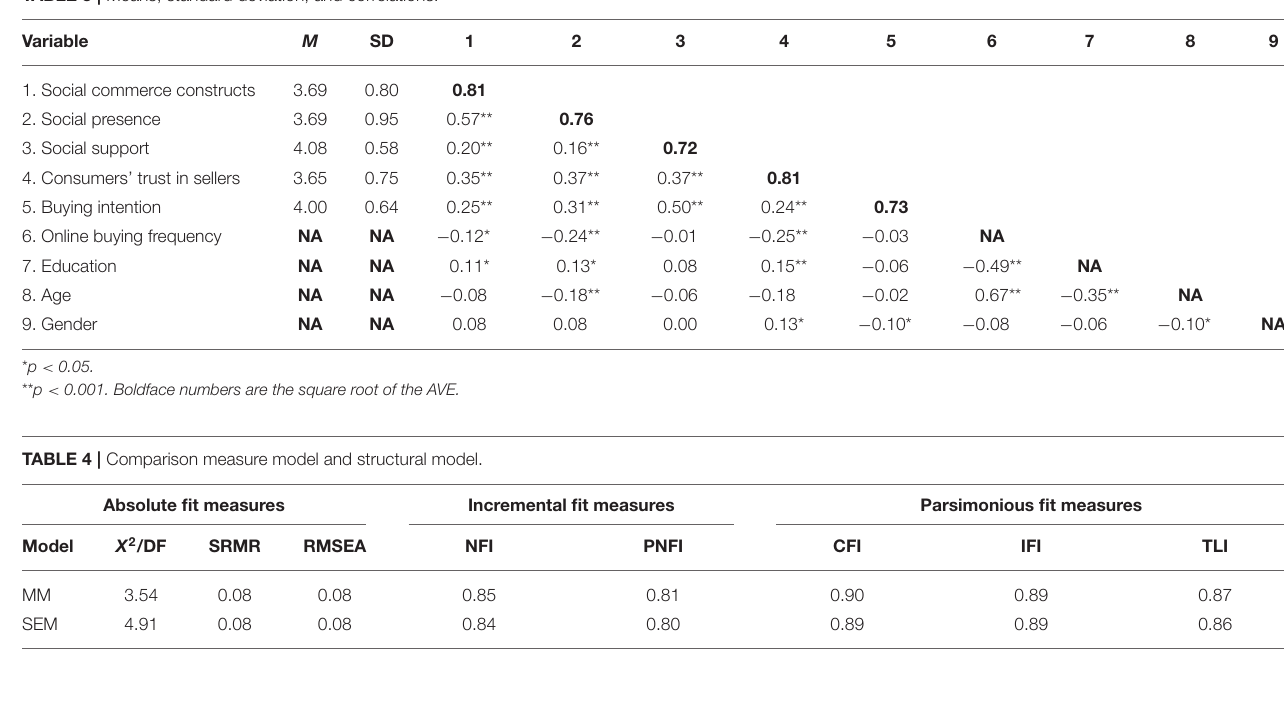
TABLE 5 | Hypothesis